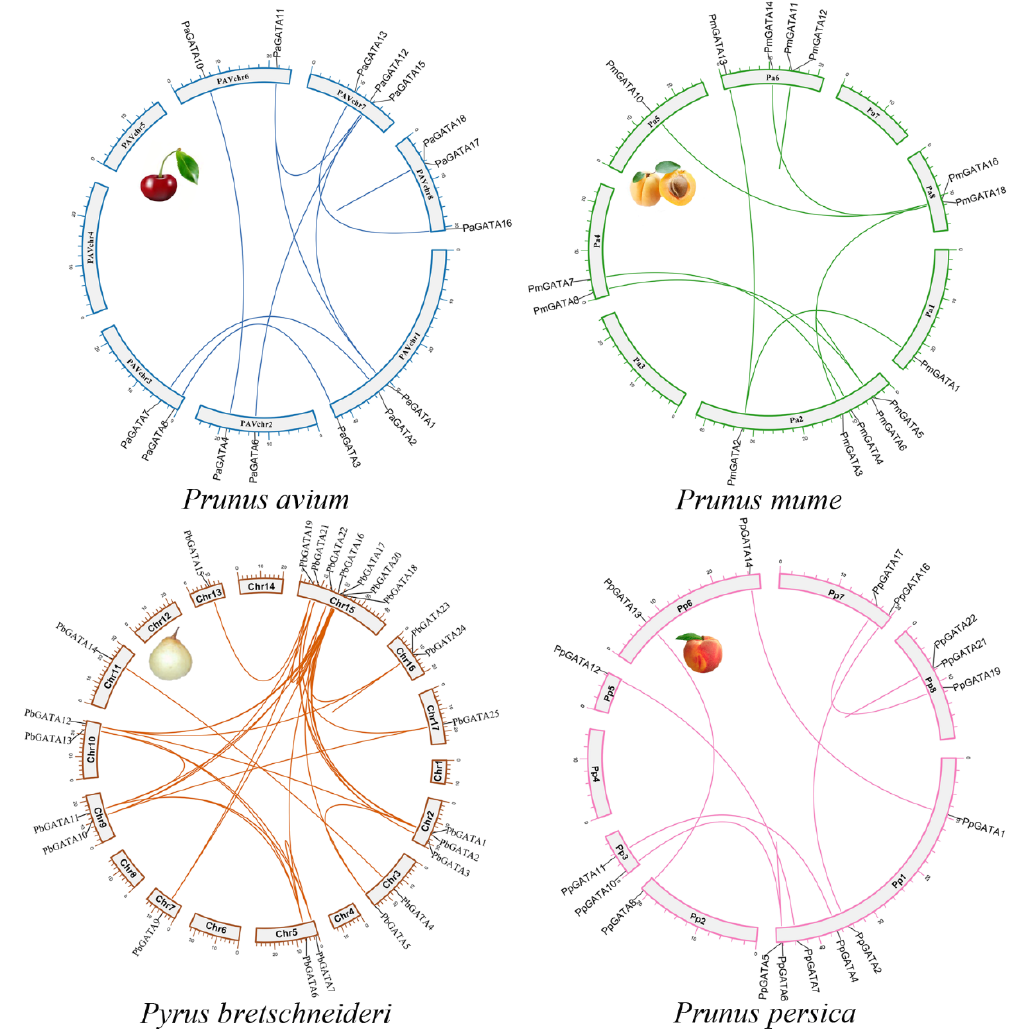
Figure 5. Gene duplication and chromosomal localization of Prunus avium , Prunus mume , Prunus persica , and Pyrus bretschneideri. Duplicated gene pairs are linked with a colored line.